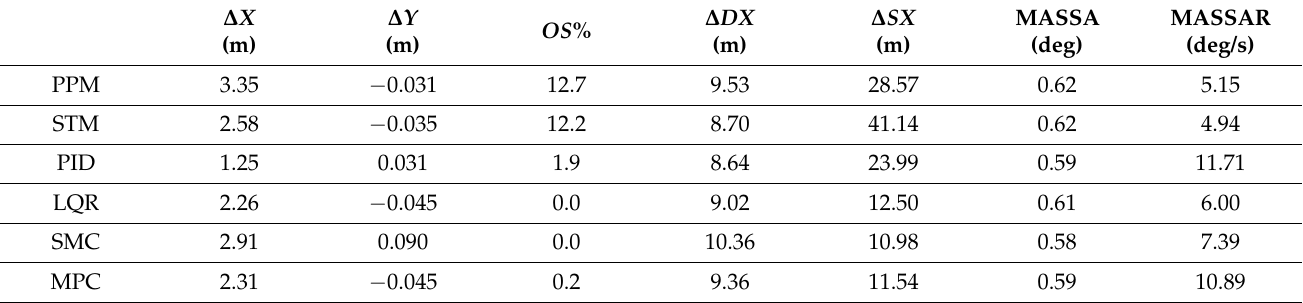
Table 6. Summary of simulation results of each controller for FWS vehicle in the third set of simulations.